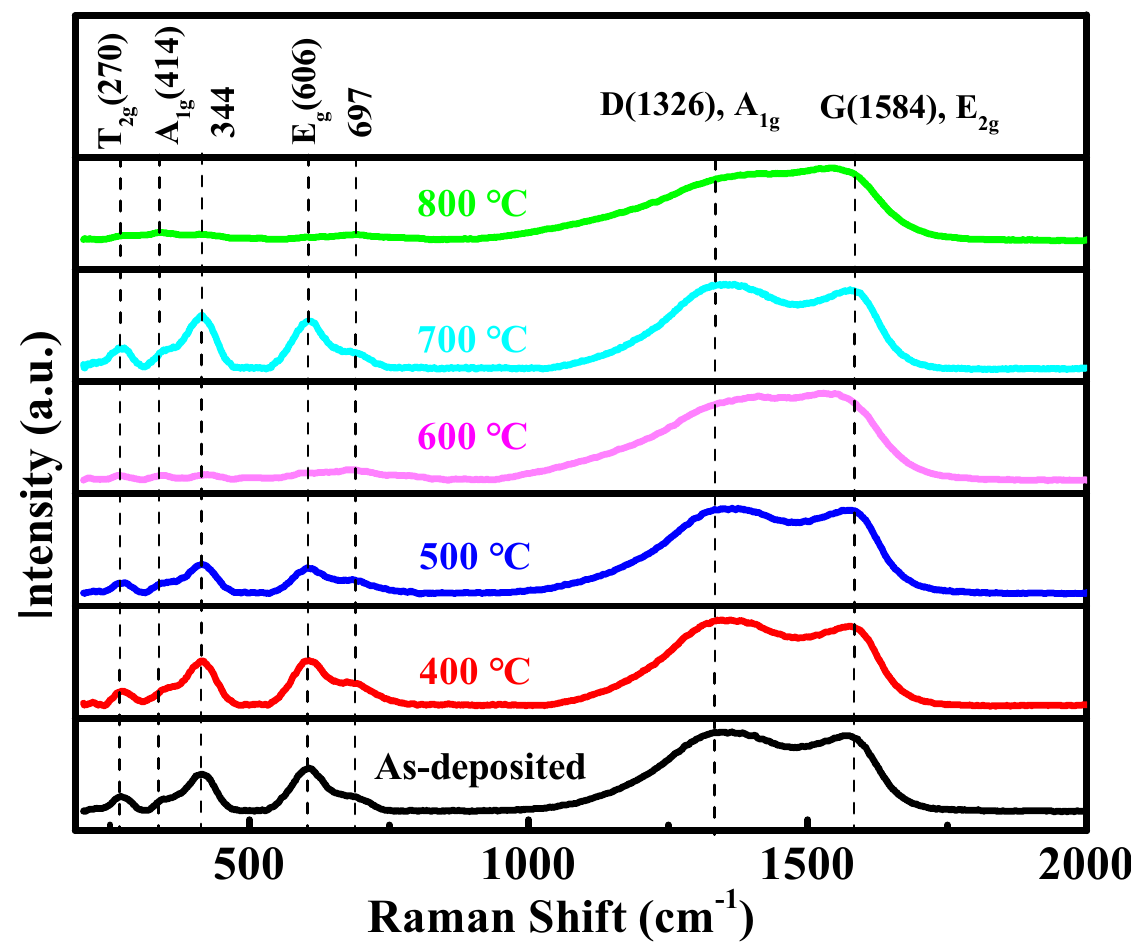
Figure 5. Raman spectra of as-deposited and annealed TiC thin films with a thickness of 610 nm.